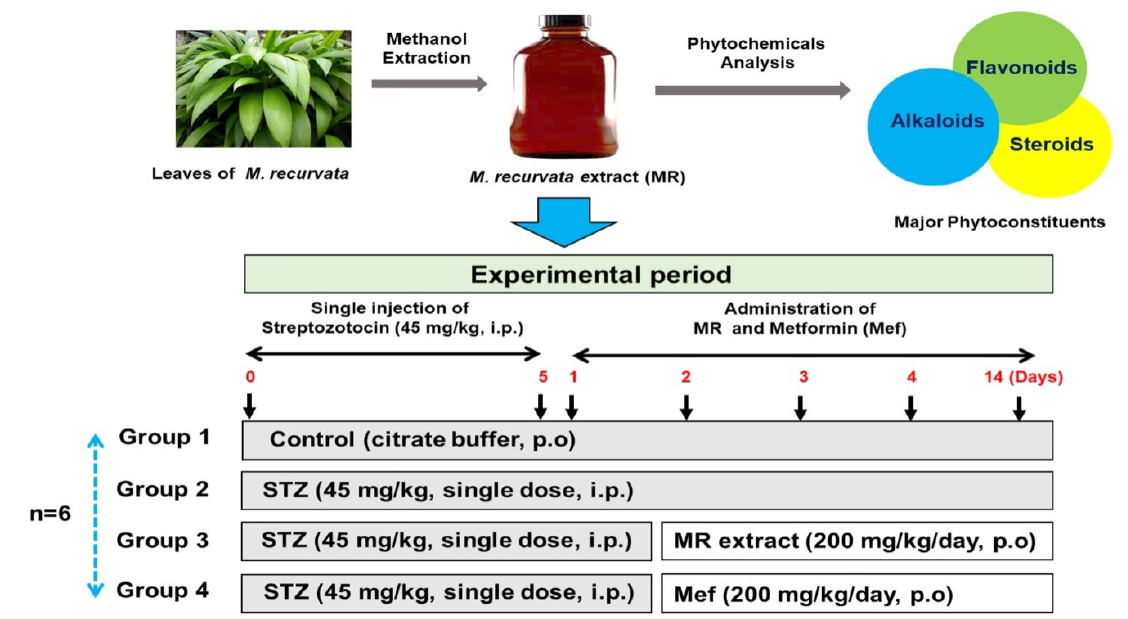
Figure 6. Experimental plan. Diabetes was induced by a single intraperitoneal (i.p.) injection of STZ (45 mg/kg). Citrate buffer was administered to the normal control group ( n = 6). After 5 days of STZ treatment, the remaining rats were divided randomly into three groups: the STZ group ( n = 6), STZ + MR (200 mg/kg of MR extract) group ( n = 6), and the STZ + Mef (200 mg/kg) group ( n = 6). The subsequent two groups (group 3 and 4) received MR extract and Mef (standard drug), respectively, for a total of 14 days. STZ: Streptozotocin, Mef: Metformin, and MR: Molineria recurvate. p.o.: mouth orally